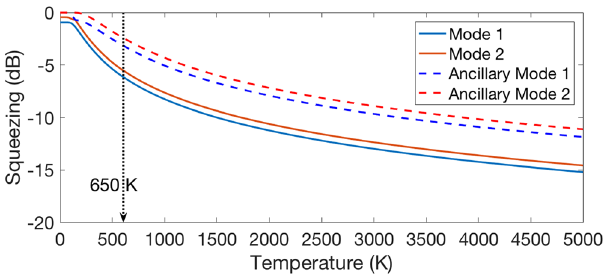
Figure 2. Franck-Condon profile of the photoelectron spectroscopy of sulfur dioxide anion ( − SO finite temperature (650 K). The sticks are calculated with classical computer and the red curves are taken from the molecular spectroscopic experiment 33 .